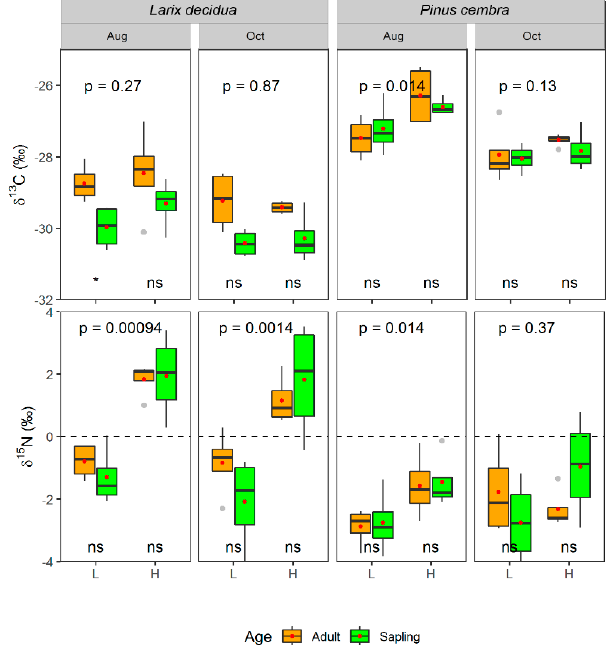
Figure 4. Leaf stable isotopes ( δ 13 C‰; δ 15 N‰) (mean ± SE, n = 4) of different species ( Pinus cembra L. and Larix decidua Mill.), age (sapling and adult tree), altitude (L for timberline and H for treeline), season (August for mid-growing season and October for late season). Asterisks or “ns” at the bottom of subplot indicate significant ( p < 0.05) or non-significant ( p > 0.05) differences between saplings and adults within the same altitude and season, and the p -value at the top of subplot denote significance level by the Wilcoxon’s mean test between L and H.